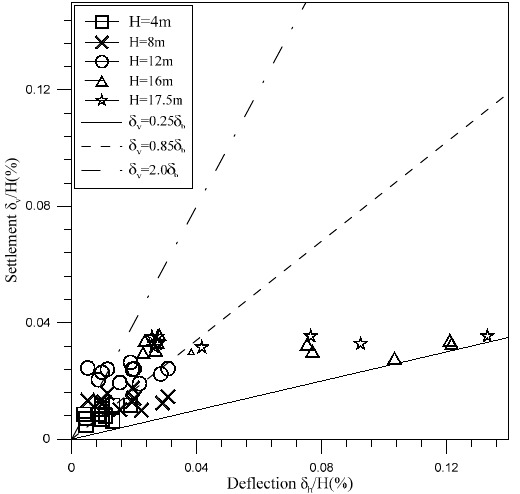
Figure 21. Deflection and settlement of the retaining wall (nodes 12–22).